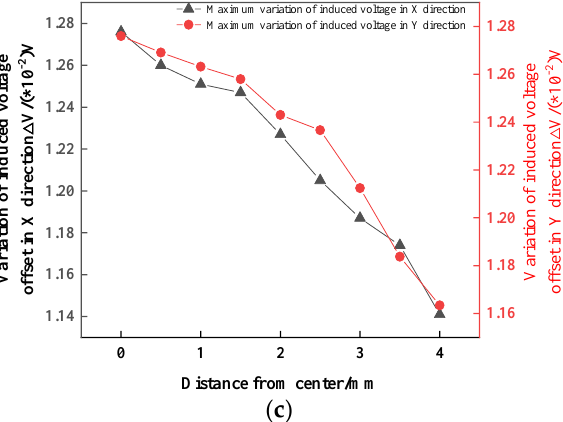
Figure 13. Influence of excitation coil/detection coil relative position on signal. ( a ) The induced voltage varies with permeability when the X direction is offset. ( b ) The induced voltage varies with permeability when the Y direction is offset. ( c ) Detection coil offset distance change influence curve.